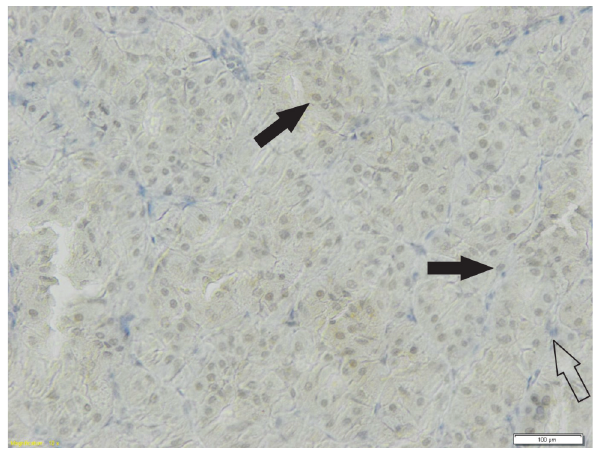
Fig. 5. Warthin’s tumour. Weak VEGF-D immunoreaction in the nuclei of both layers of some oncocytic cells (black arrow), moderate to strong nuclear positivity in stromal lymphocytes (white arrow).